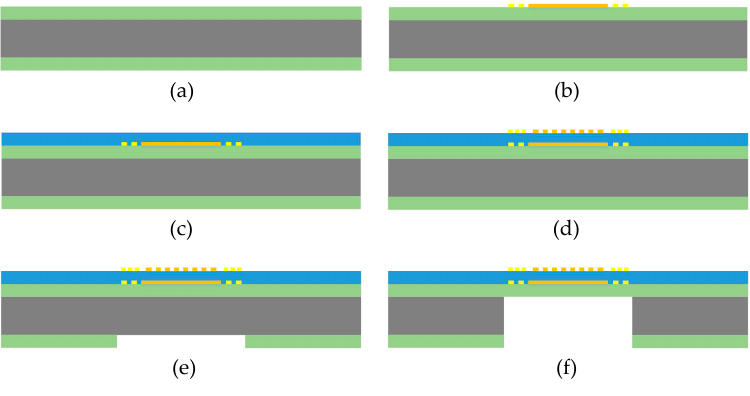
Figure. 3 Fabrication process for the sensor chip.